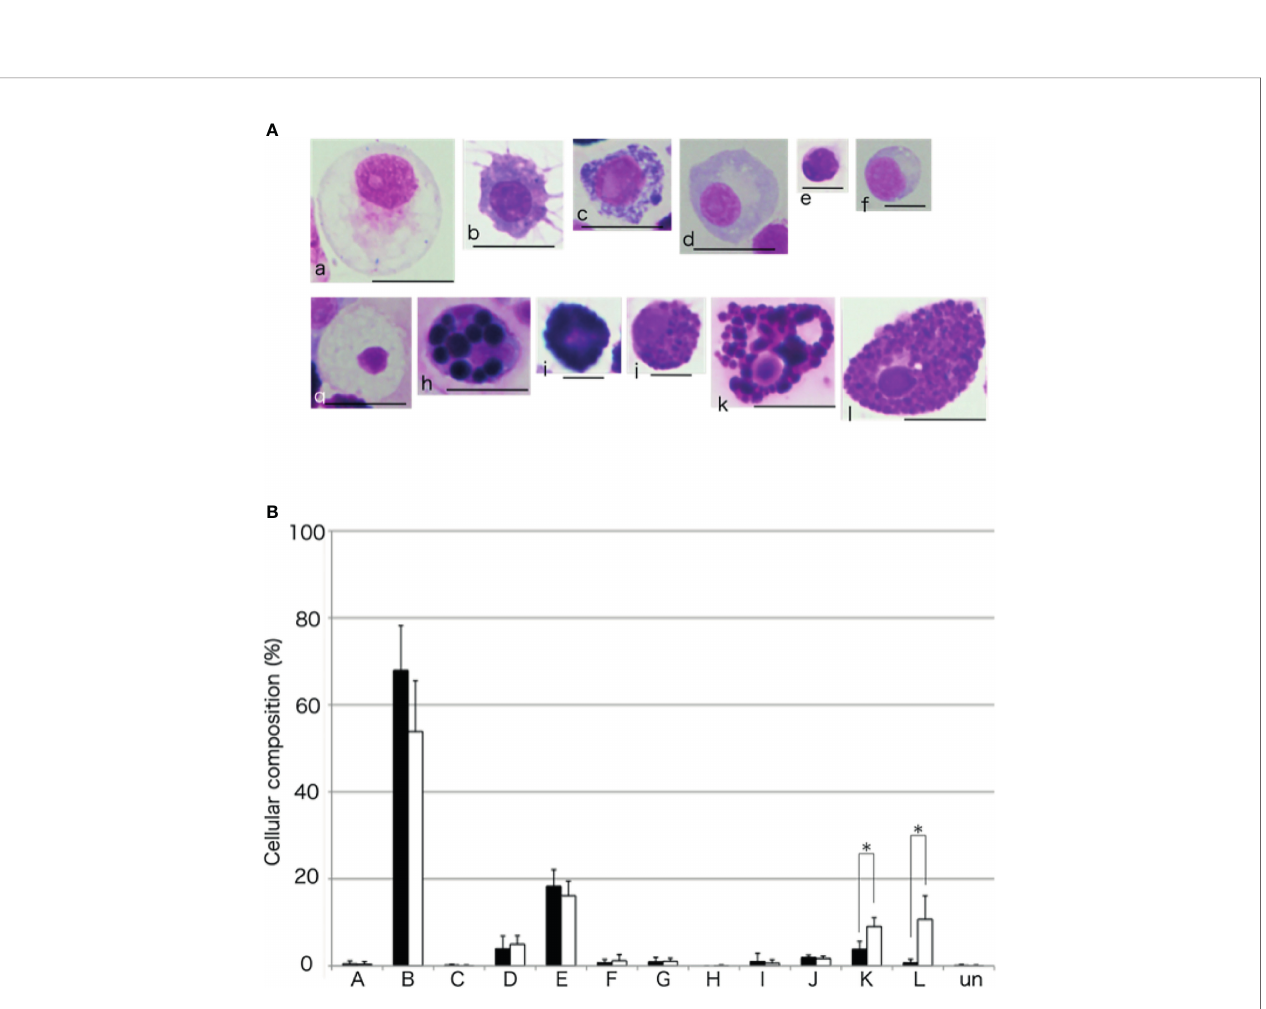
FIGURE 11 | Cellular composition of the aggregates. (A) The coelomocytes of A. japonicus classi fi ed based on MG staining. a to l indicate Type-A to Type-L, respectively. Un, unidenti fi ed. Scale bars are 5 (e and f) or 10 mm (a, b, c, d, g, h, i, j, k, and l). (B) Comparison of cellular composition of aggregates formed in the presence or absence of the intestinal extract. opened bar; absence, closed bar; intestinal extract. * P < 0.05 (mean ± SD, n =